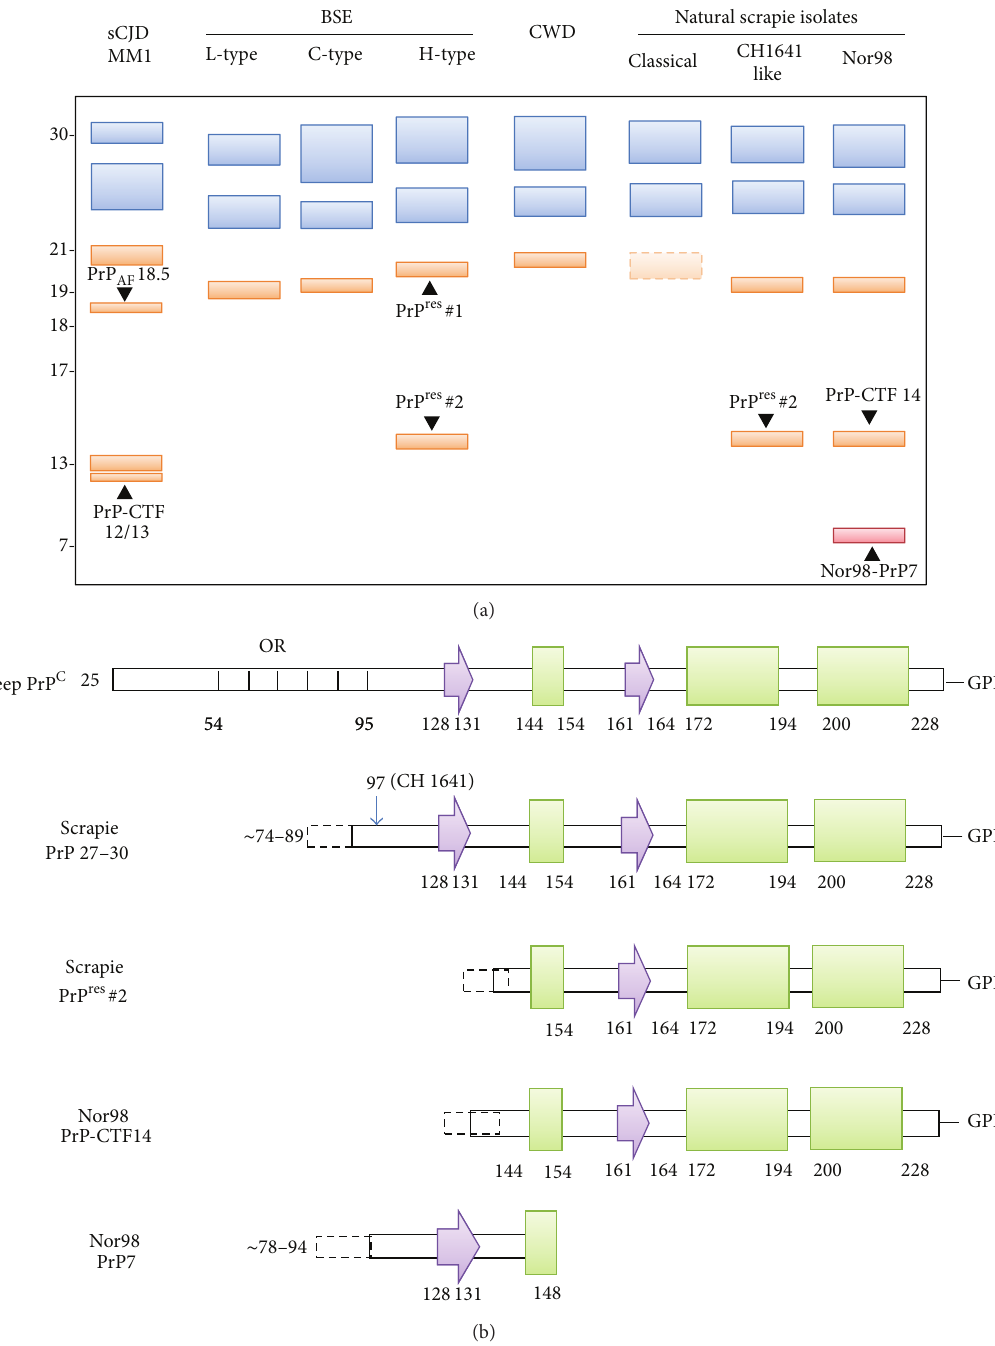
Figure2:(a)SchematicrepresentationofthespectrumofPrP res fragmentsobservedinanimalpriondiseasesandtheirelectrophoreticprofile. The unglycosylated forms of all PrP res fragments with the glycosylation sites in their sequence are indicated in orange, while the fragments lacking these sites are shown in red. Among the glycosylated peptides, only the mono- and the diglycosylated forms of PrP res 27–30 (18–21kDa range) fragments are shown (in blue). To facilitate the comparison with human forms, the profile of MM1 sCJD associated PrP res is shown; note that the unglycosylated band of sCJDMM1 PrP res has the same electrophoretic mobility of that of CWD as reported by Xie et al. [14]. (b) Diagrams of the secondary structural elements of sheep PrP C and of the PK-resistant PrP fragments observed in classical and atypical Nor98 scrapie. Arrows are representative of 𝛽 -strands and rectangles of 𝛼 -helices and OR indicates the octapeptide repeats region. The secondary structure numbering has been derived from pdb (Protein Data Bank) id 1XYU (sheep